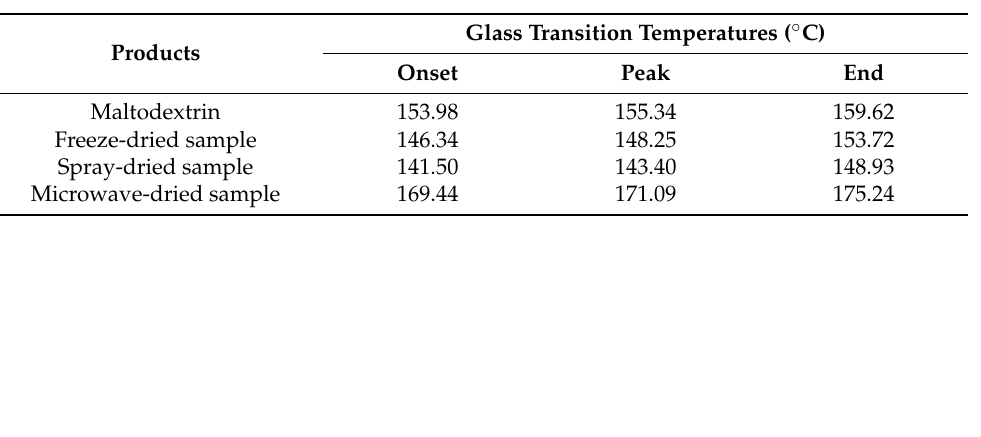
Table 6. Glass transition temperatures of maltodextrin and encapsulated